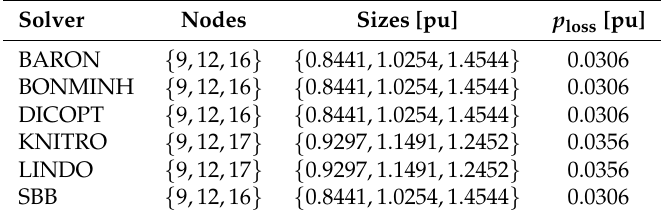
Table 3. Comparison of the MI-SDP with the MINLP model solved in GAMS for the 21-node test feeder. Solver Nodes Sizes [pu] p loss [pu] BARON { 9,12,16 }